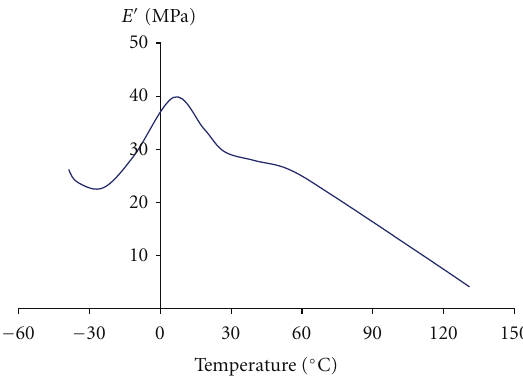
Figure 3: E ff ect of frequency on DMTA spectrum (tan δ ) of pure PP: (1) 0.1Hz, (2) 0.3 Hz, (3) 1 Hz, (4) 5 Hz, (5) 10 Hz, (6) 50 Hz, and (7) 100